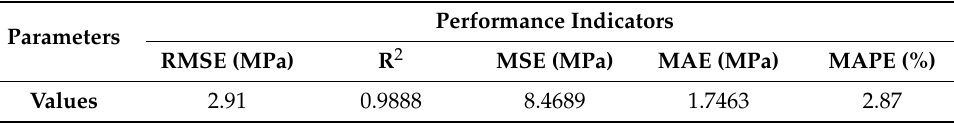
Table 5. Values of model performance accuracy parameters.